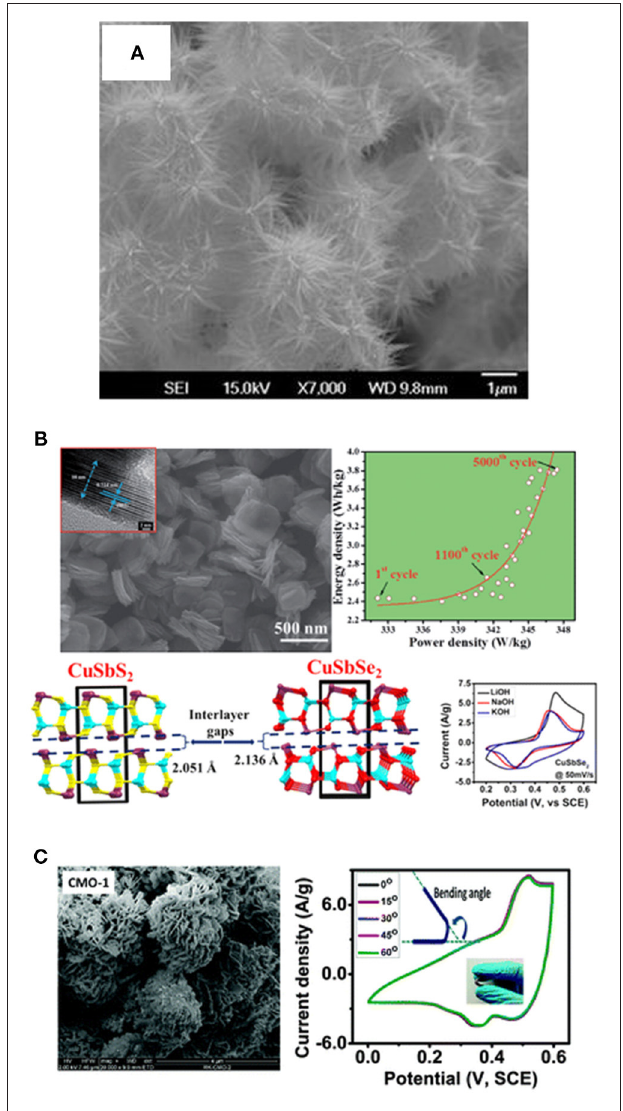
FIGURE 2 | Advanced pseudocapacitive materials for supercapacitor electrodes. (A) scanning electron microscope (SEM) image of NiCo 2 O 4 nanocrystals grown on nickel foam, an attractive electrode material for variable temperature operation; Copyright: Scientific Reports, (Gupta et al., 2015) (B) top, SEM image and power density of layered ternary sulfide CuSbS 2 nanoplates; Copyright: Journal of Materials Chemistry A (Ramasamy et al., 2015) and bottom, CuSbSe 2 mesocrystals with controlled inter-layer gap; Copyright: Chemistry of Materials, (Ramasamy et al., 2014a) and (C) SEM image of CoMoO 4 nanocrystals and CV curves at different bending angles of the flexible device; Copyright: New Journal of Chemistry (Candler et al.,